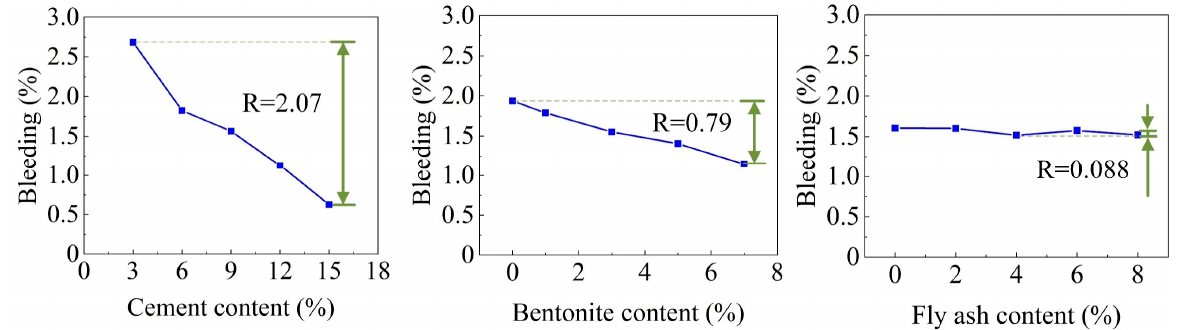
Figure 8. Range analysis of bleeding